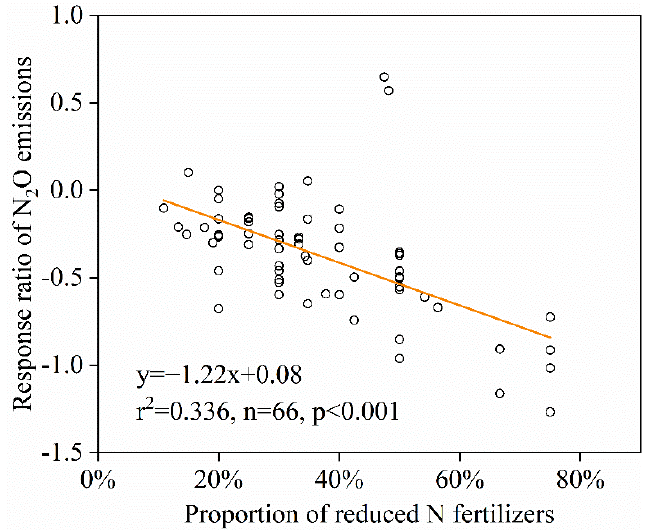
Figure 6. Relationship of the response ratio of N 2 O emissions against the proportion of reduced N input rates relative to the full amount of N fertilizers.